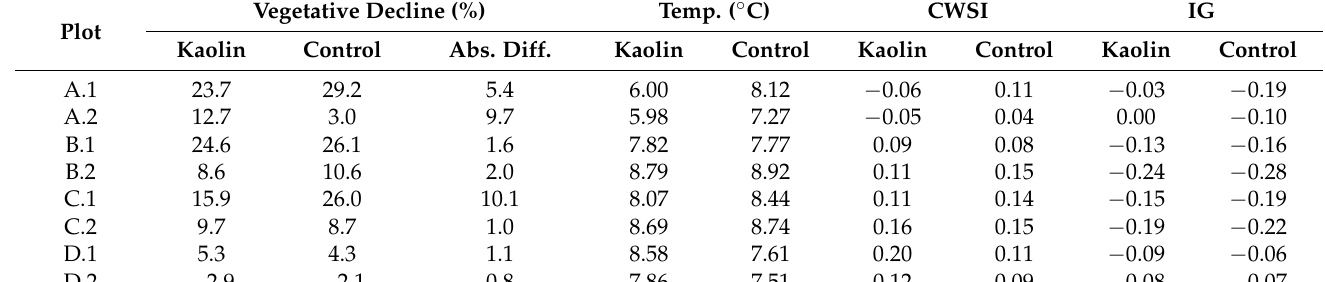
11 of 18 Table 4. Relative difference between the two periods for the grapevine vegetation area decline and estimated parameters from the thermal infrared imagery in each plot. Data represents the difference between September to August mean plot values of kaolin ‐ treated plants with respect to the control